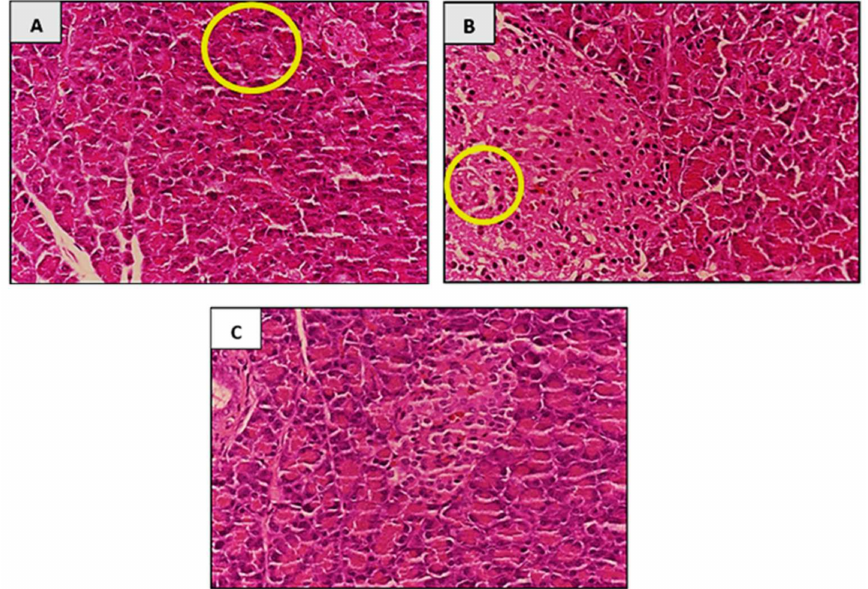
Figure 4. Histopathological analysis of pancreas after 18 days of treatment (EtOAc extract 400 mg kg − 1 dose); ( A ) Presence of islet atrophy in STZ-induced group. ( B ) Presence of insuli- tis in the STZ-induced group. ( C ) No presence of cellular atrophy and insulitis in the group treated with P. tetrastromatica